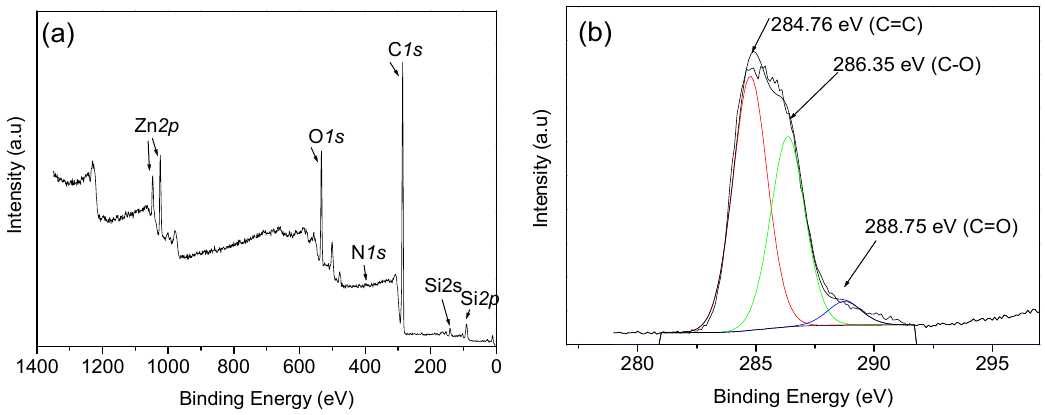
Figure 2. ( a ) XPS spectra of latex, ( b ) deconvoluted C1s region of X-ray photoelectron spectra for latex.